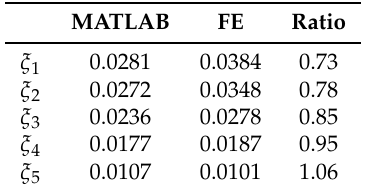
Table 1. Comparison between MATLAB and Straus7 displacements.